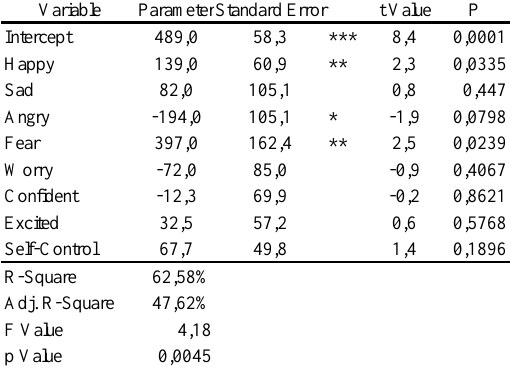
Table 6: Regression of Manager's Total Profit on Emotional State Variable